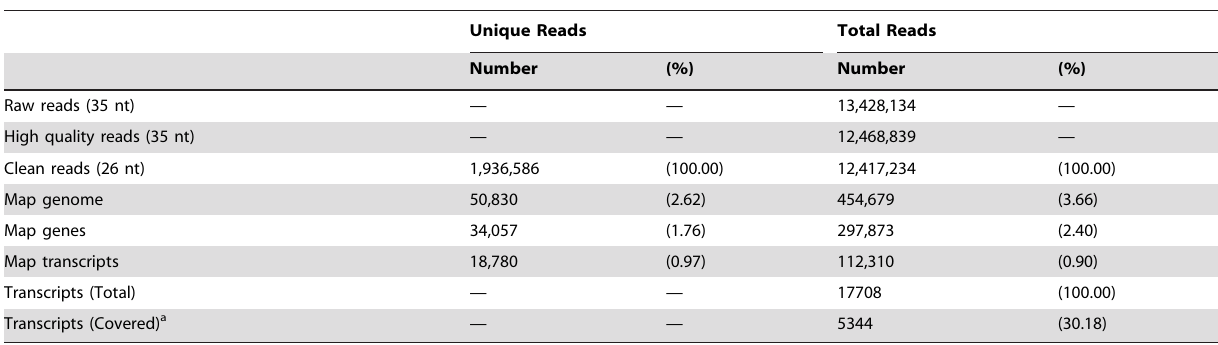
Table 3. Summary of the degradome